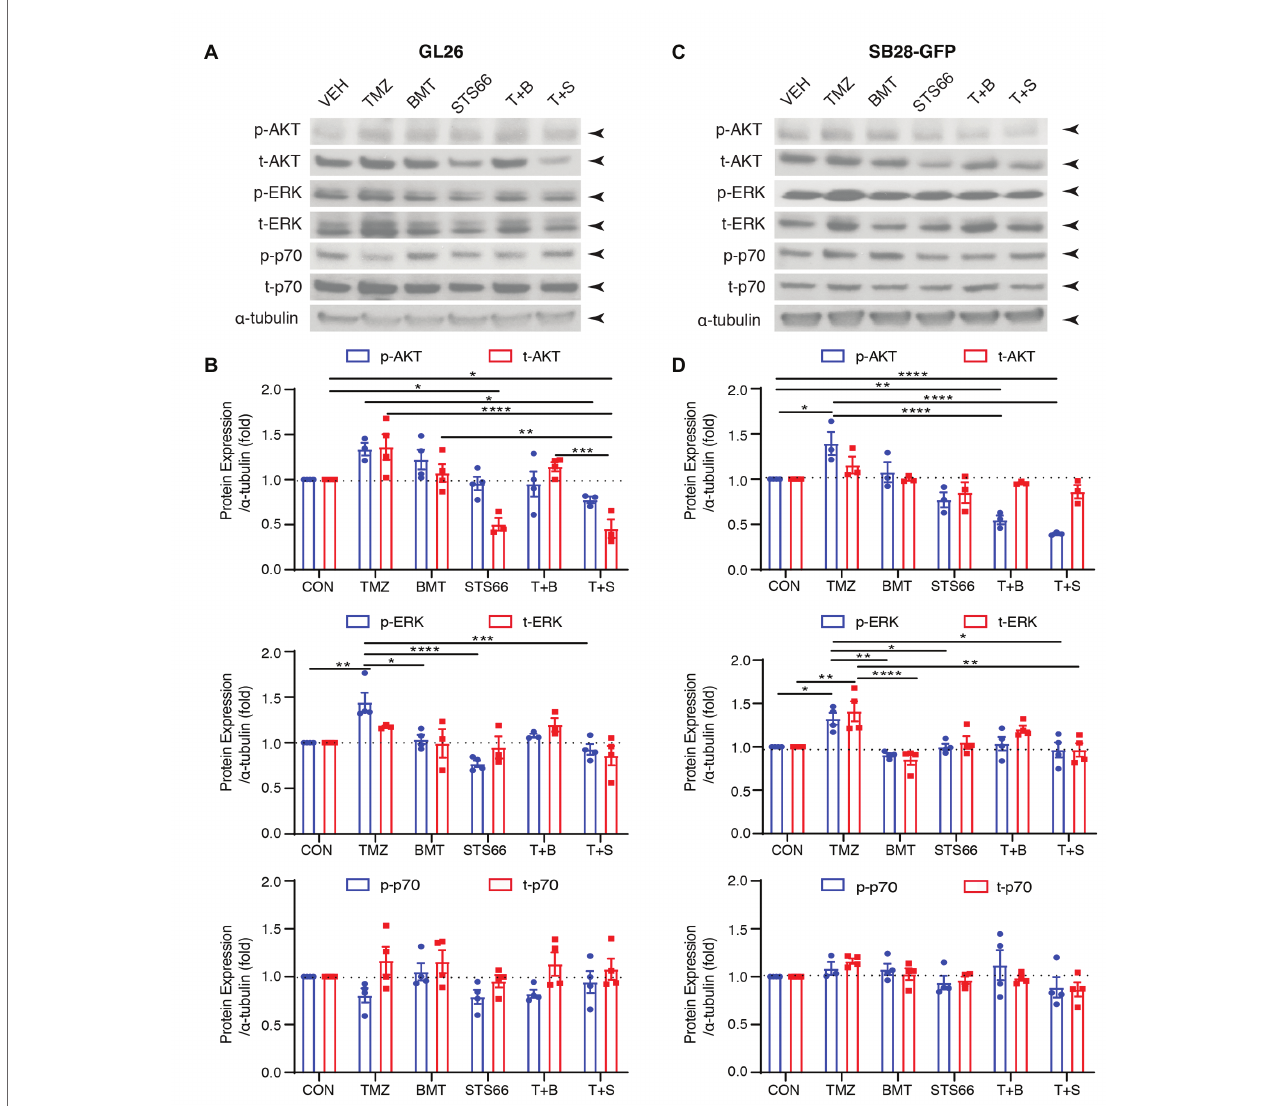
FIGURE 5 | STS66 reduced activation of AKT and ERK but not mTOR protein in cultured glioma cells in response to TMZ. (A) Representative immunoblotting images of phosphorylated (p-) or total (t-) AKT, ERK, and p70 of the same cohorts of immunoblots in Figure 4 . (B) Summary. Data are means ± SEM ( n = 3, 4), * p < 0.05, ** p < 0.01, *** p < 0.001, **** p < 0.0001. (C) Representative immunoblotting images of phosphorylated (p-) or total (t-) AKT, Erk and p70 of the same cohorts of immunoblots in Figure 4 . (D) Summary. Data are means ± SEM ( n = 3, 4), * p < 0.05, ** p < 0.01, *** p < 0.001, **** p < 0.0001. All blots were re-stripped and re-probed from the same blots of Figure 4 and the original tubulin blots were used for normalization